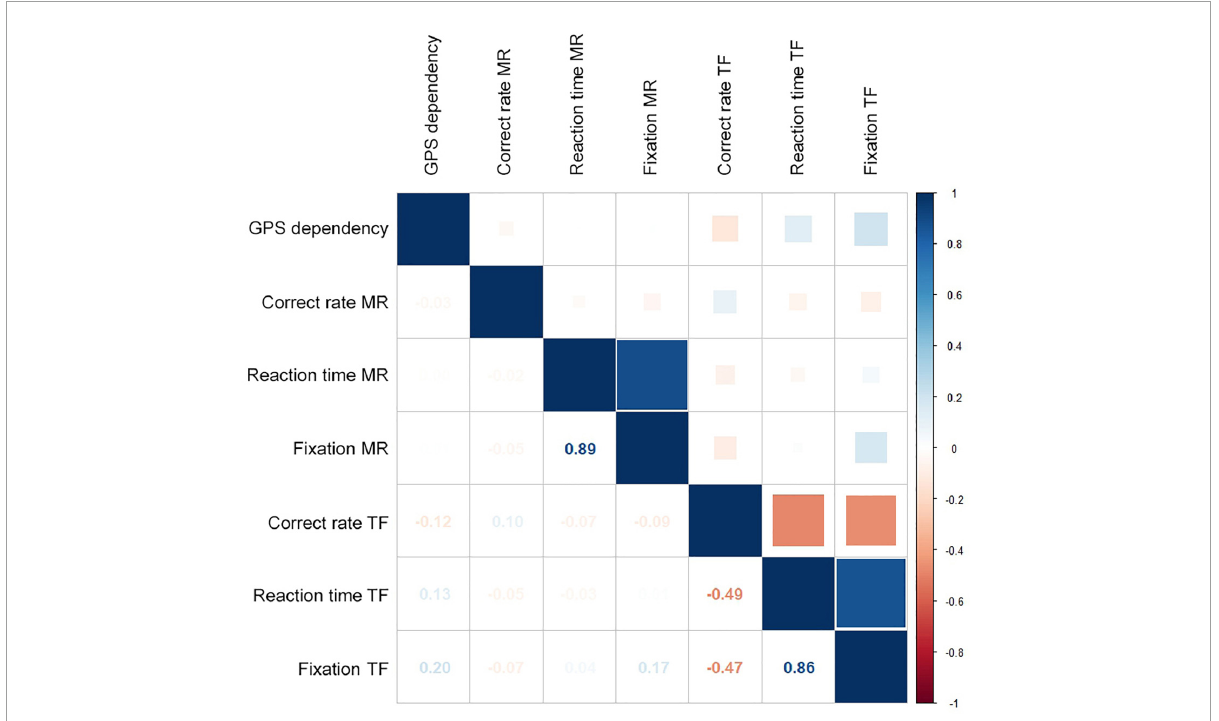
FIGURE3 Correlation between GPS dependency score and indicators in eye-tracking tasks. Blue represents the positive correlation, and red represents the negative correlation. The numbers in the grids represent the correlation coefficient. MR represents mental rotation task. TF represents target finding